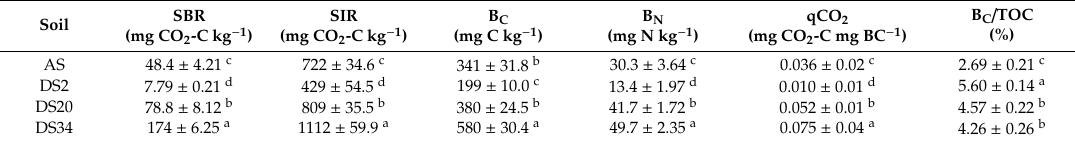
Table 2. Basal respiration of the arable soil and de-sealed soils.